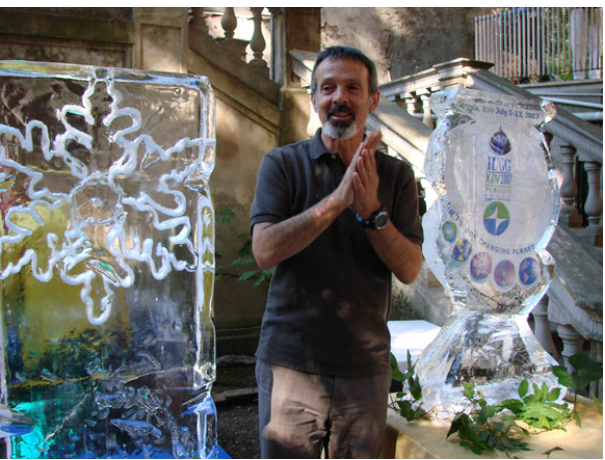
Figure 2. IUGG’s congratulations on the occasion of the birth of IACS. Featured is Georg Kaser, the first IACS President (source: IUGG